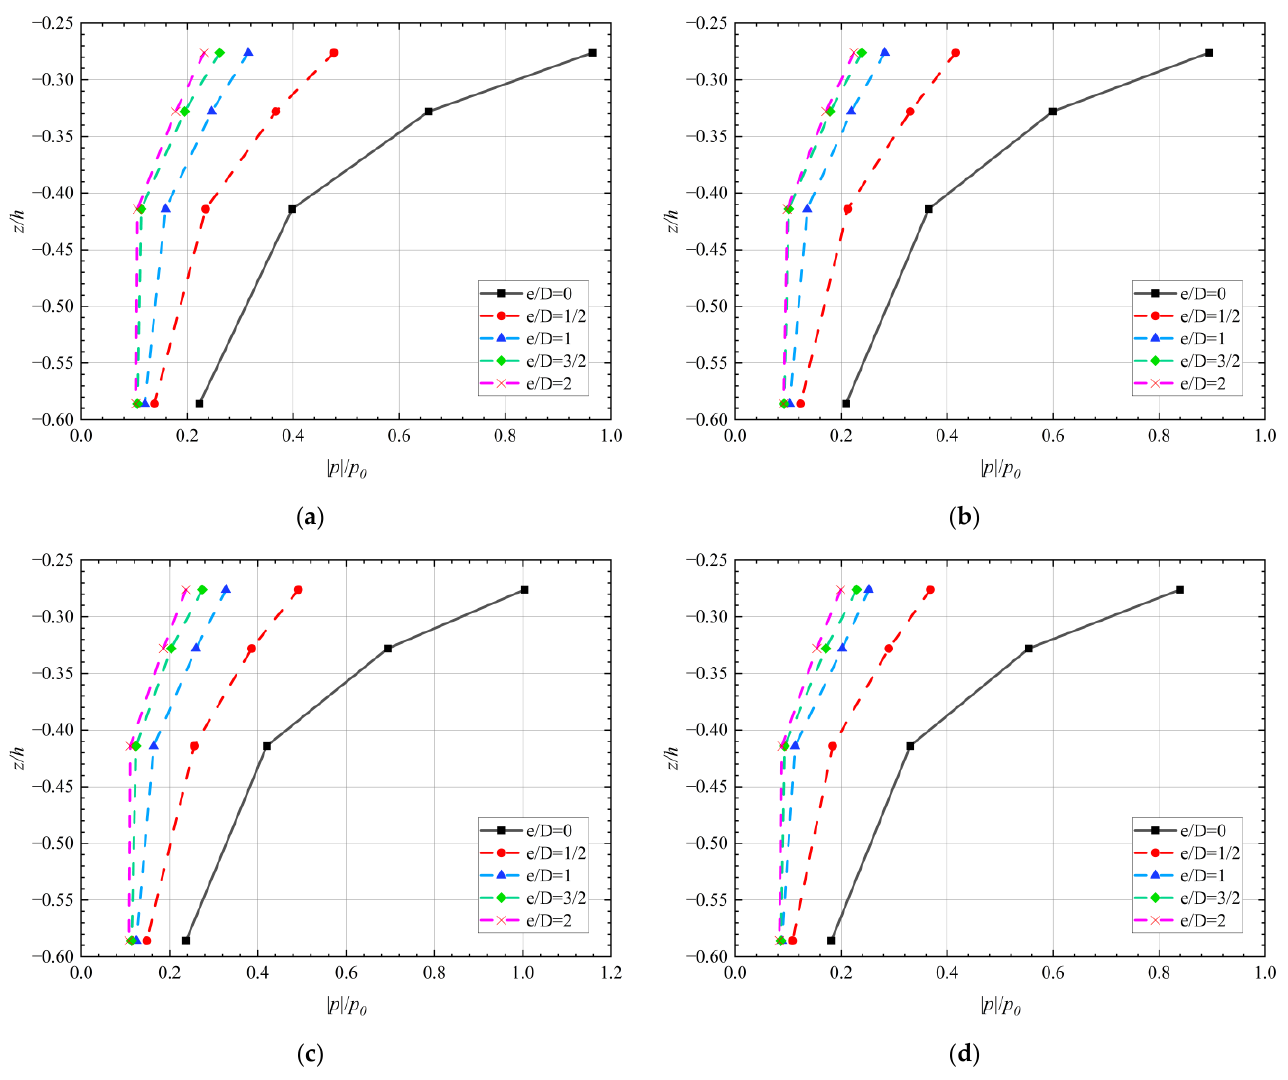
Figure A4. Variation of the dimensionless pore pressure amplitude beneath the pipeline under different backfill depths and current conditions ( 𝑈 𝑐 = ± 0.1 m/s, ± 0.2 m/s). ( a ) 𝑈 𝑐 = 0.1 m/s; ( b ) 𝑈 𝑐 = − 0.1 m/s; ( c ) 𝑈 𝑐 = 0.2 m/s; ( d ) 𝑈 𝑐 = − 0.2 m/s.